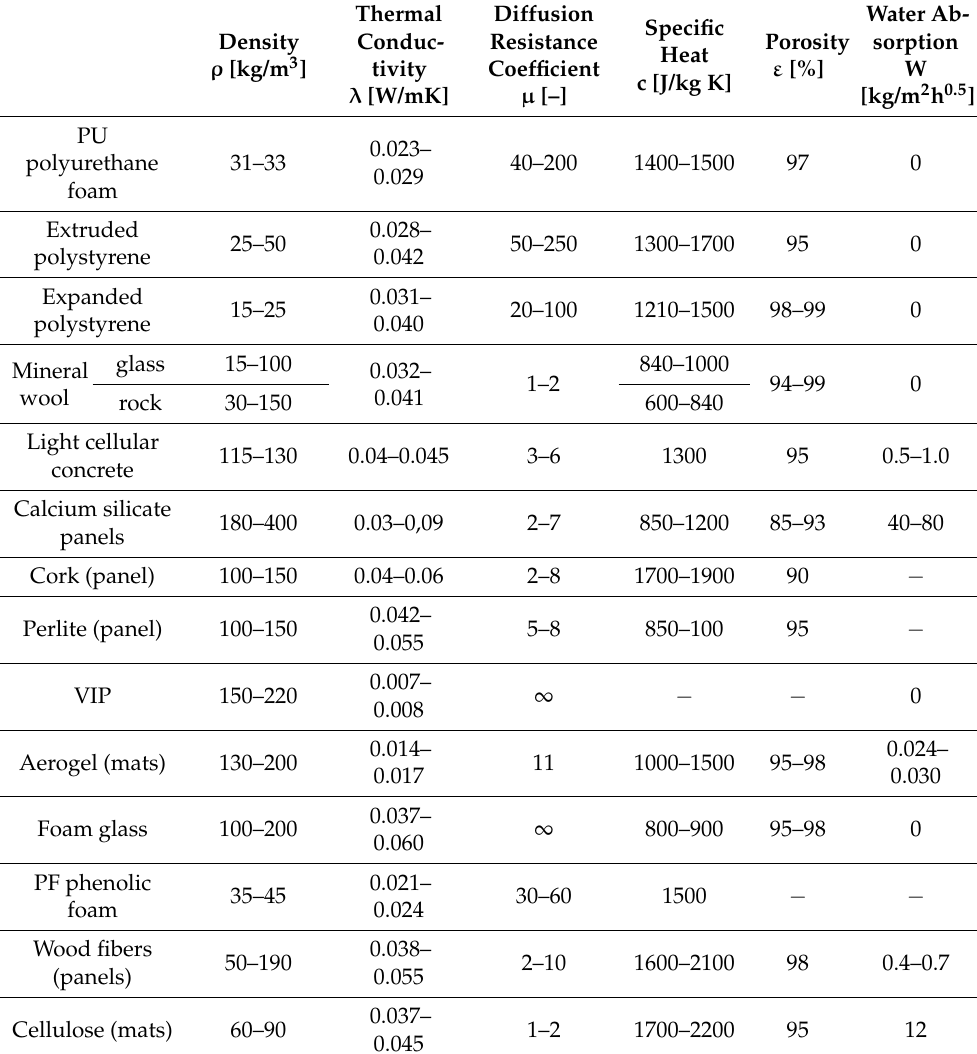
Table 1. Selected thermal insulations from the inside; materials and components